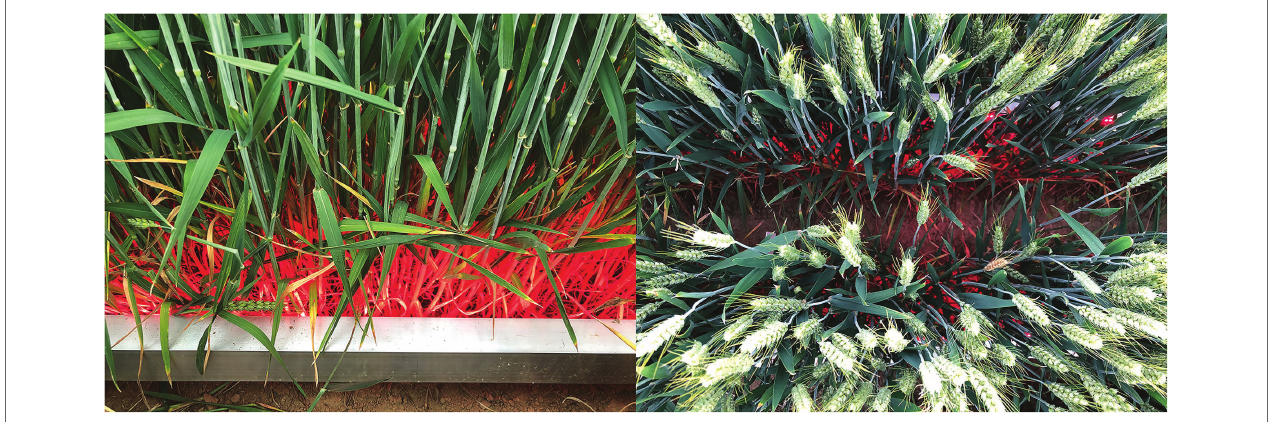
FIGURE 1 | Supplementary light irradiation